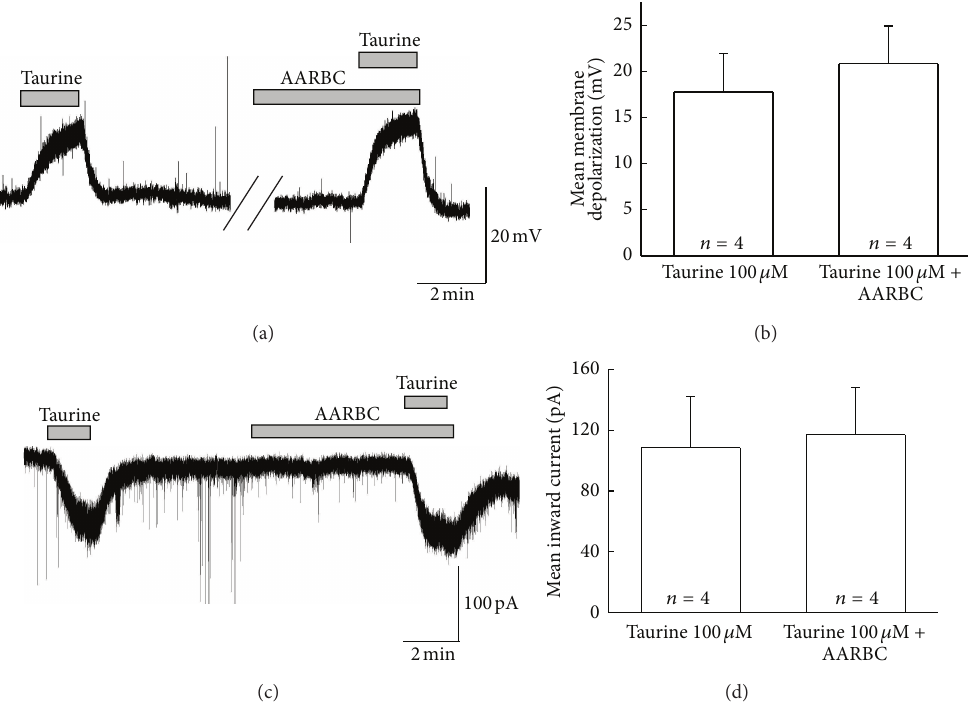
Figure 2: Taurine-induced membrane depolarizations and taurine-induced currents are mediated by postsynaptic SG neurons. (a), (c) The representative traces showing membrane depolarization and inward current induced by taurine (100 𝜇 M) alone and taurine in the presence of AARBC. (b), (d) Bar graphs showing the comparisons of mean relative membrane depolarization and mean inward current by the taurine alone and taurine in the presence of AARBC ( 𝑃 > 0.05